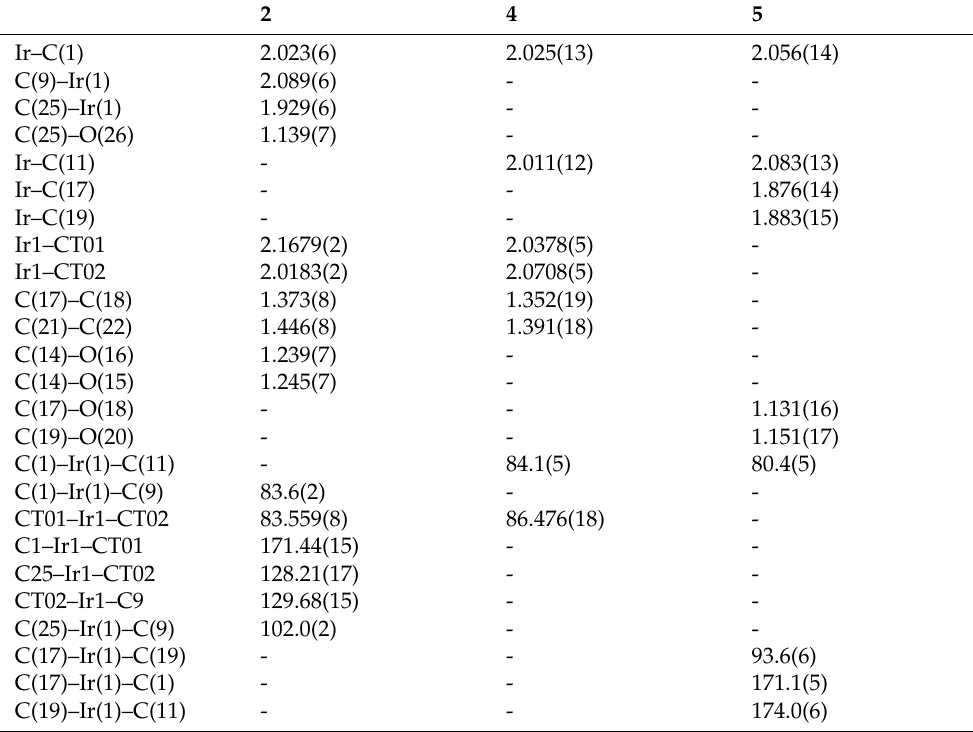
Table 1. Selected bond lengths (Å) and angles ( ◦ ) in 2 · 2 CH 3 OH, 4 · 1.75 CH 2 Cl 2 , and 5 · CH 2 Cl 2